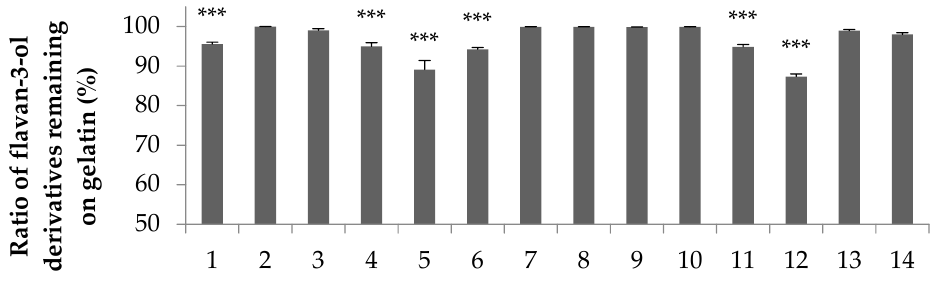
Figure 1. Chemical structures of flavan-3-ol derivatives adsorbed on gelatin.